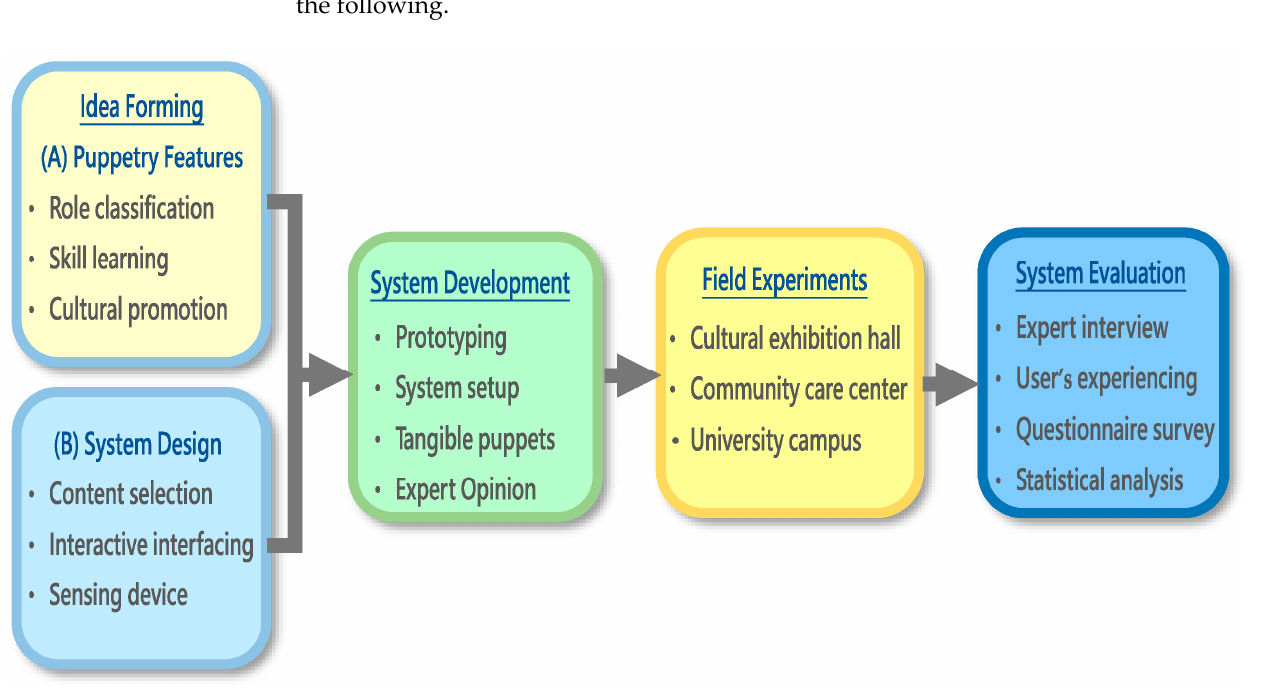
Figure 3. Research Framework (the terms in this figure appear in Section 1.5 above as italic words).